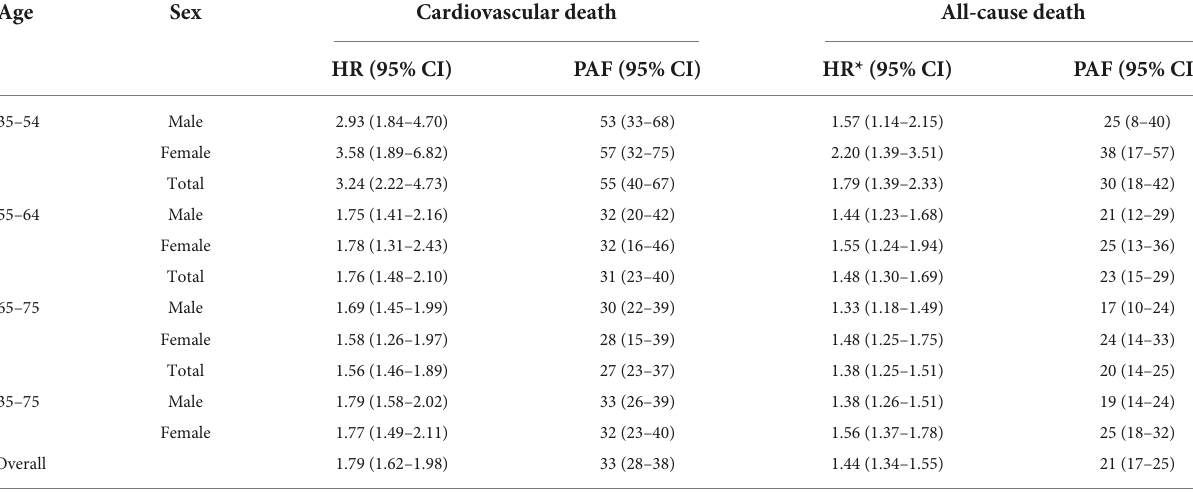
TABLE 2 Age- and sex-specific proportions of cardiovascular and all-cause deaths attributable to elevated blood pressure